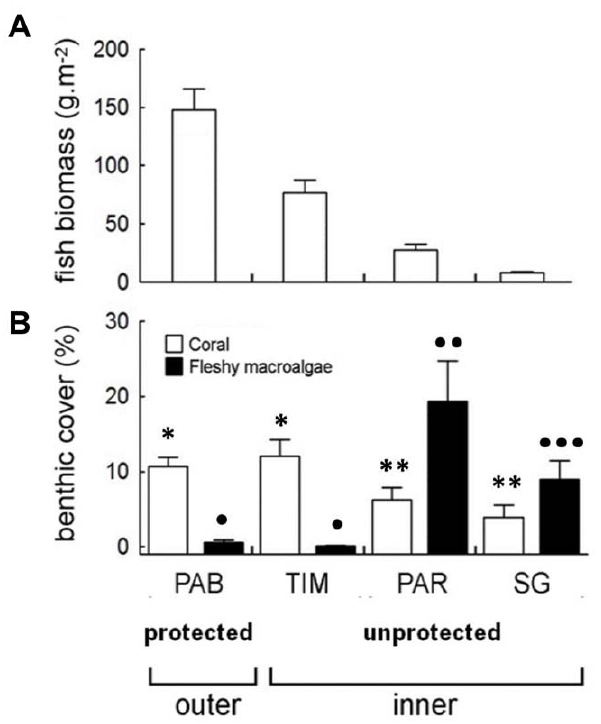
Figure 2. Marine macro rganisms. A ) Fish biomass and B ) benthic cover (coral and macroalgae) in the protected reef Parcel do Abrolhos (PAB) and the unprotected reefs Timbebas (TIM), Pedra de Leste (PAR) and Sebastia˜o Gomes (SG). The stars and black circles represent significant differences (ANOVA, p , 0.05) in the coral and fleshly algae